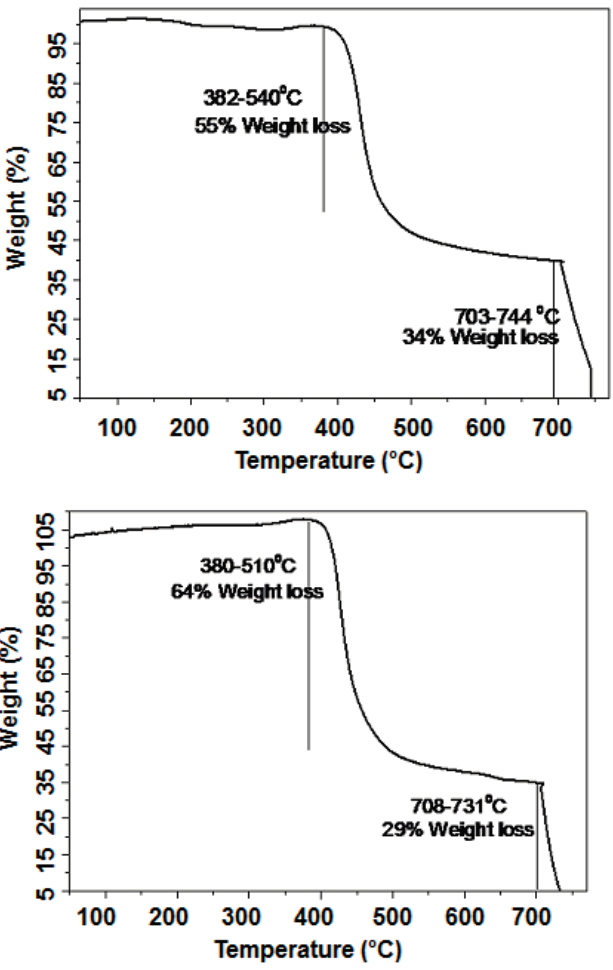
Figure 6. TGA traces of S10 (upper) and S11 (lower) under nitrogen atmosphere. Heating rate: 10 °C/min from room temperature to 800